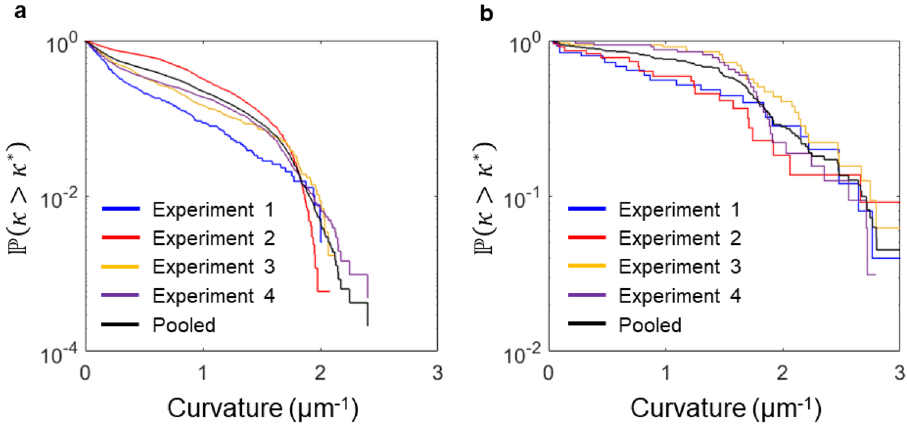
Figure 4. Distributions of curvatures of pinned microtubule segments and of breaking events. ( a ) The complement of the cumulative distribution function of the curvatures of 0.5 μm microtubule segments is shown for repeated experiments with 1 mM ATP, 500 μm −2 kinesin (Experiment 1: N = 411–blue; Experiment 2: N = 1742–yellow; Experiment 3: N = 620–red, Experiment 4: N = 2165–purple). The black solid line is the cumulative distribution of pooled data from the four individual experiments. ( b ) The complement of the cumulative distribution function of the curvatures of 0.5 μm microtubule segments breaking in the next frame is shown for repeated experiments with 1 mM ATP, 500 μm −2 kinesin (Experiment 1: N = 25–blue; Experiment 2: N = 22–yellow; Experiment 3: N = 32–red, Experiment 4: N =